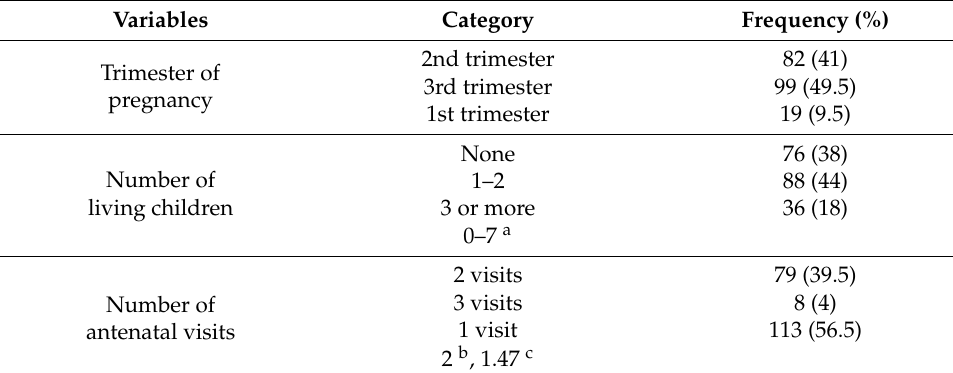
Table 2. Pregnancy-related characteristics of